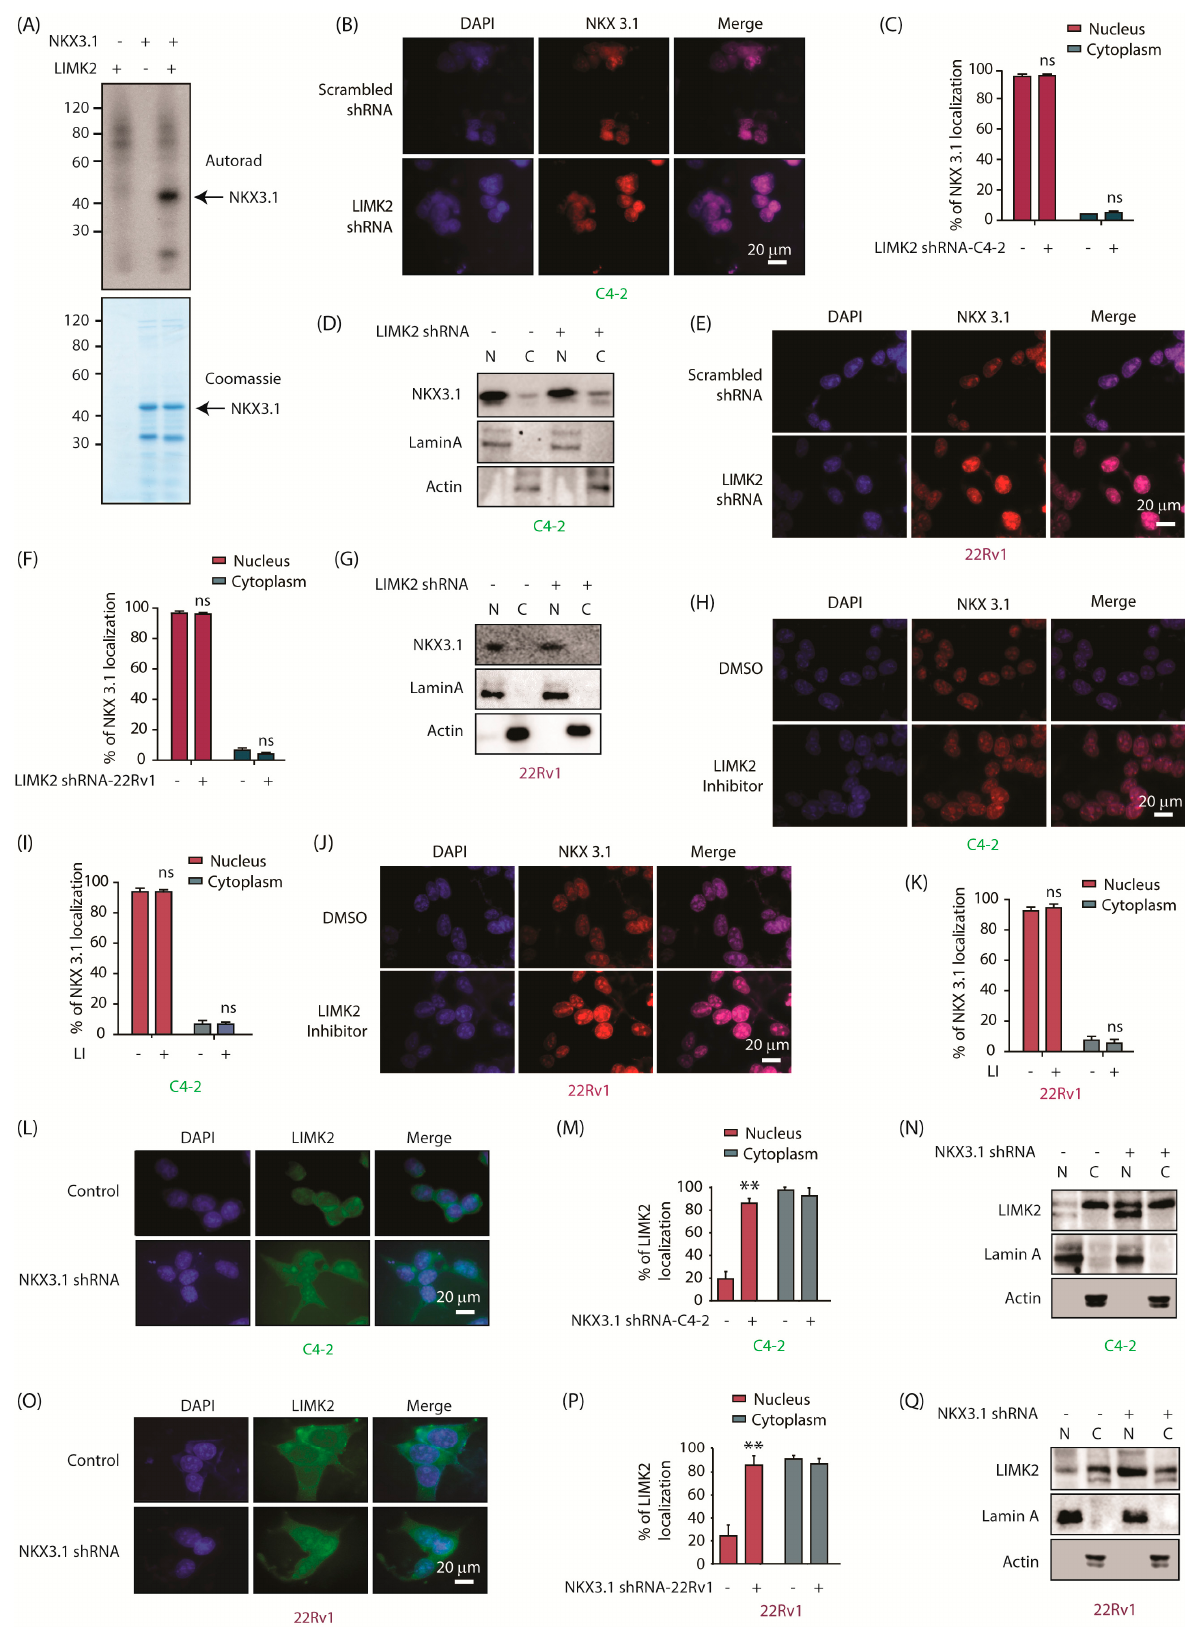
Figure 1. LIMK2 directly phosphorylates NKX3.1 and in turn, NKX3.1 regulates LIMK2 localization. ( A ) LIMK2 and NKX3.1 were incubated with [ γ - 32 P] ATP. The mixtures were separated by SDS-PAGE. NKX3.1 phosphorylation was detected